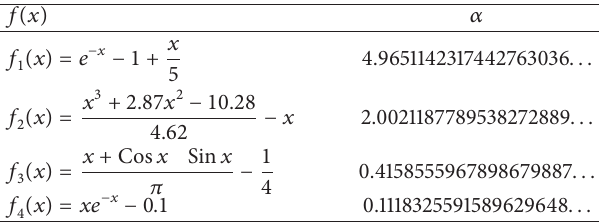
Table 1: Functions and their